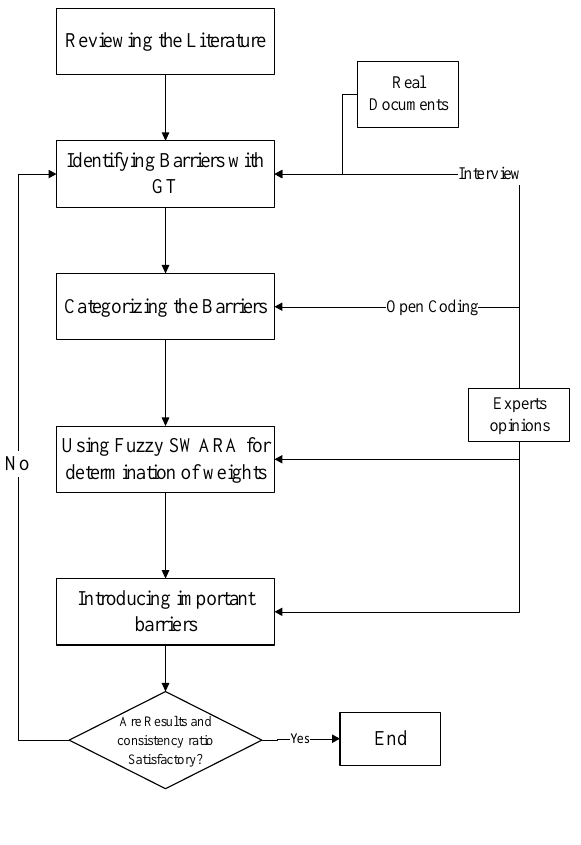
Fig. 1. Flowchart of the proposed MCDM